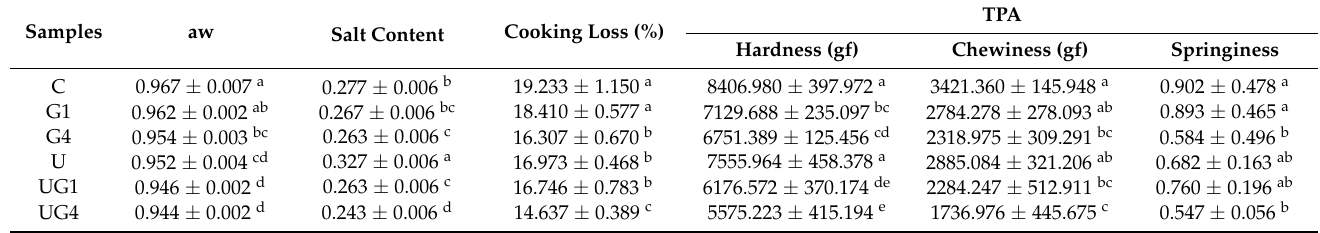
Table 1. Aw, salt content, cooking loss, and TPA under different treatment